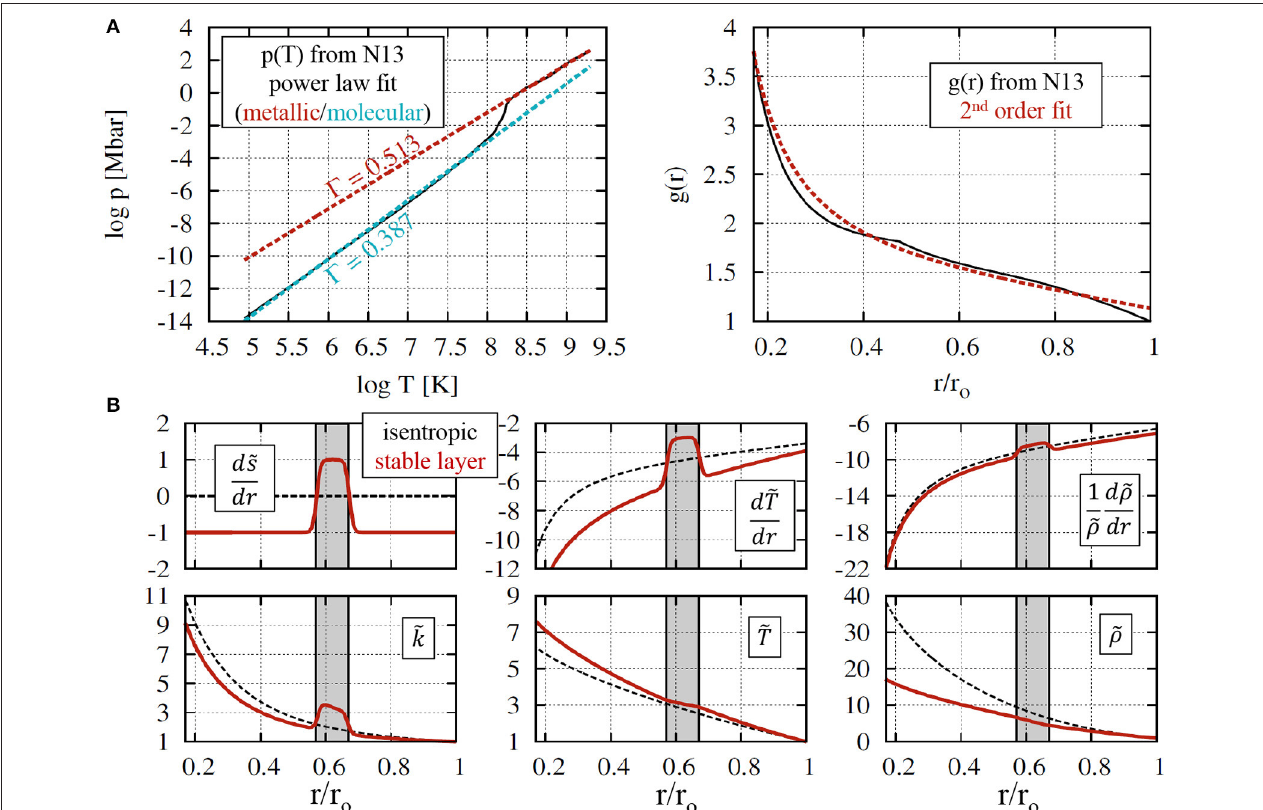
FIGURE 1 | (A) power law ( Ŵ ) and 2nd order polynomial (gravity) fits to the interior state model from Nettelmann et al. (2013) (B) the non-adiabatic background state is characterized by a prescribed entropy gradient profile ( d non-adiabaticity is strongly exaggerated (parameters ǫ s